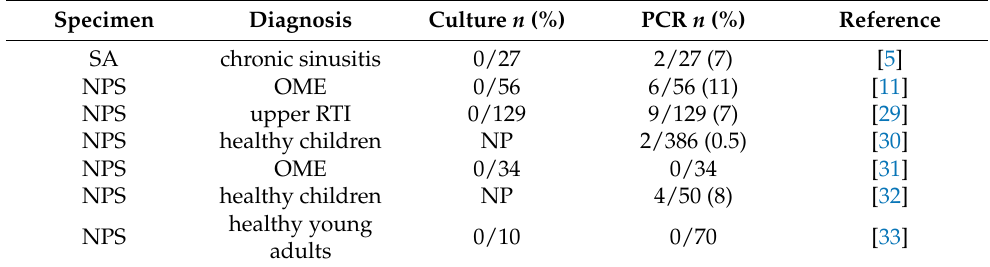
Table 1. Review of literature on detection of A. otitidis from nasopharyngeal